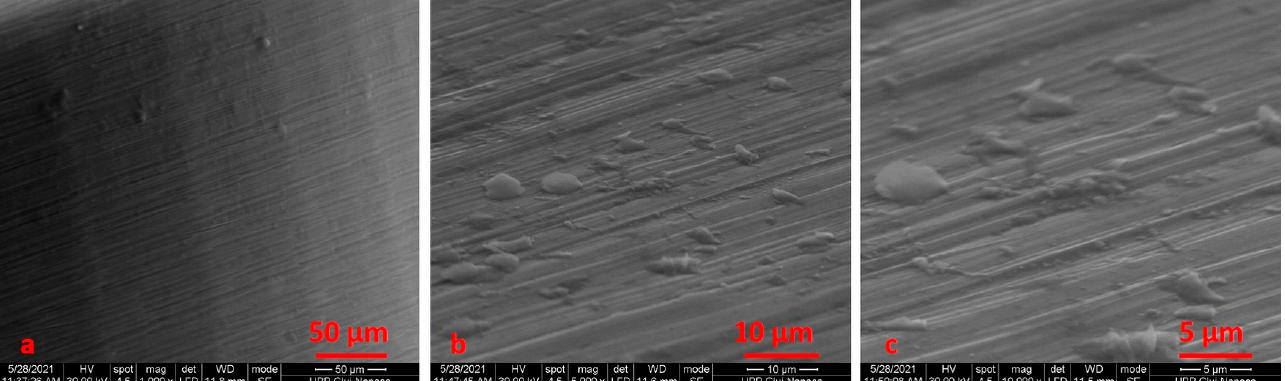
Figure 13. SEM images with mini-implants and SM at ×1000 ( a ), ×5000 ( b ), ×10,000 ( c ) magnification. Extensive bacterial colonization ( a,b,c ) on the mini-implant bodies.